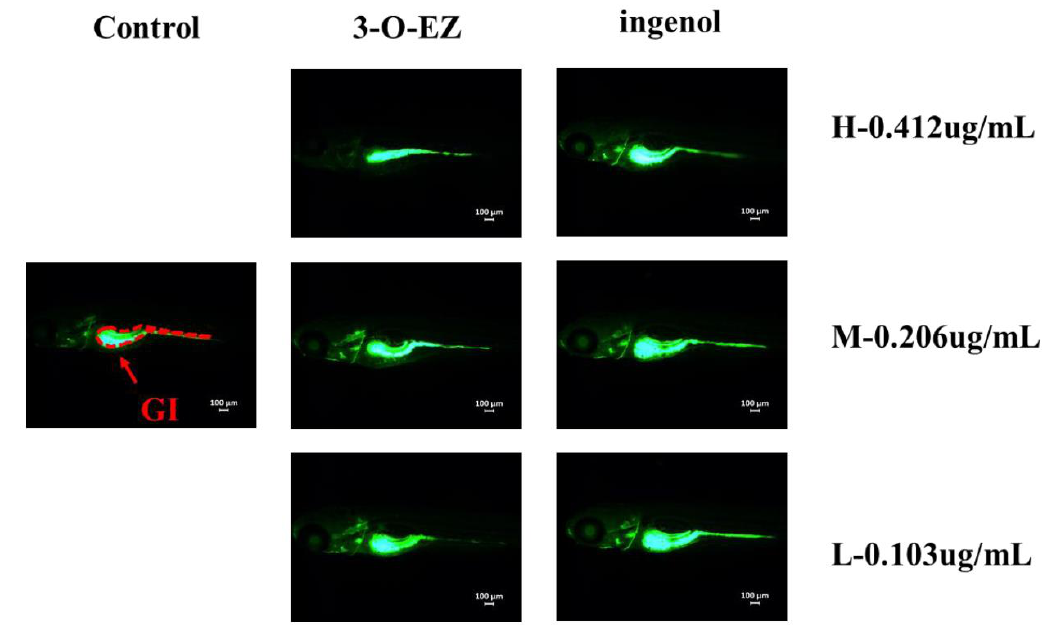
Figure 5. The results of calcein staining in the gastrointestinal (GI) tract of zebrafish embryos.